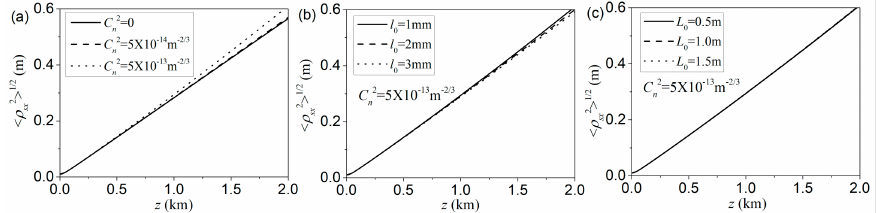
Figure 7. Evolution of the r.m.s beam width along the x -direction propagation in marine turbulence with the propagation distance z for different values of ( a ) structure constants, ( b ) inner scale sizes and ( c ) outer scale sizes. The initial coherence width in the calculation is δ 0 = 4